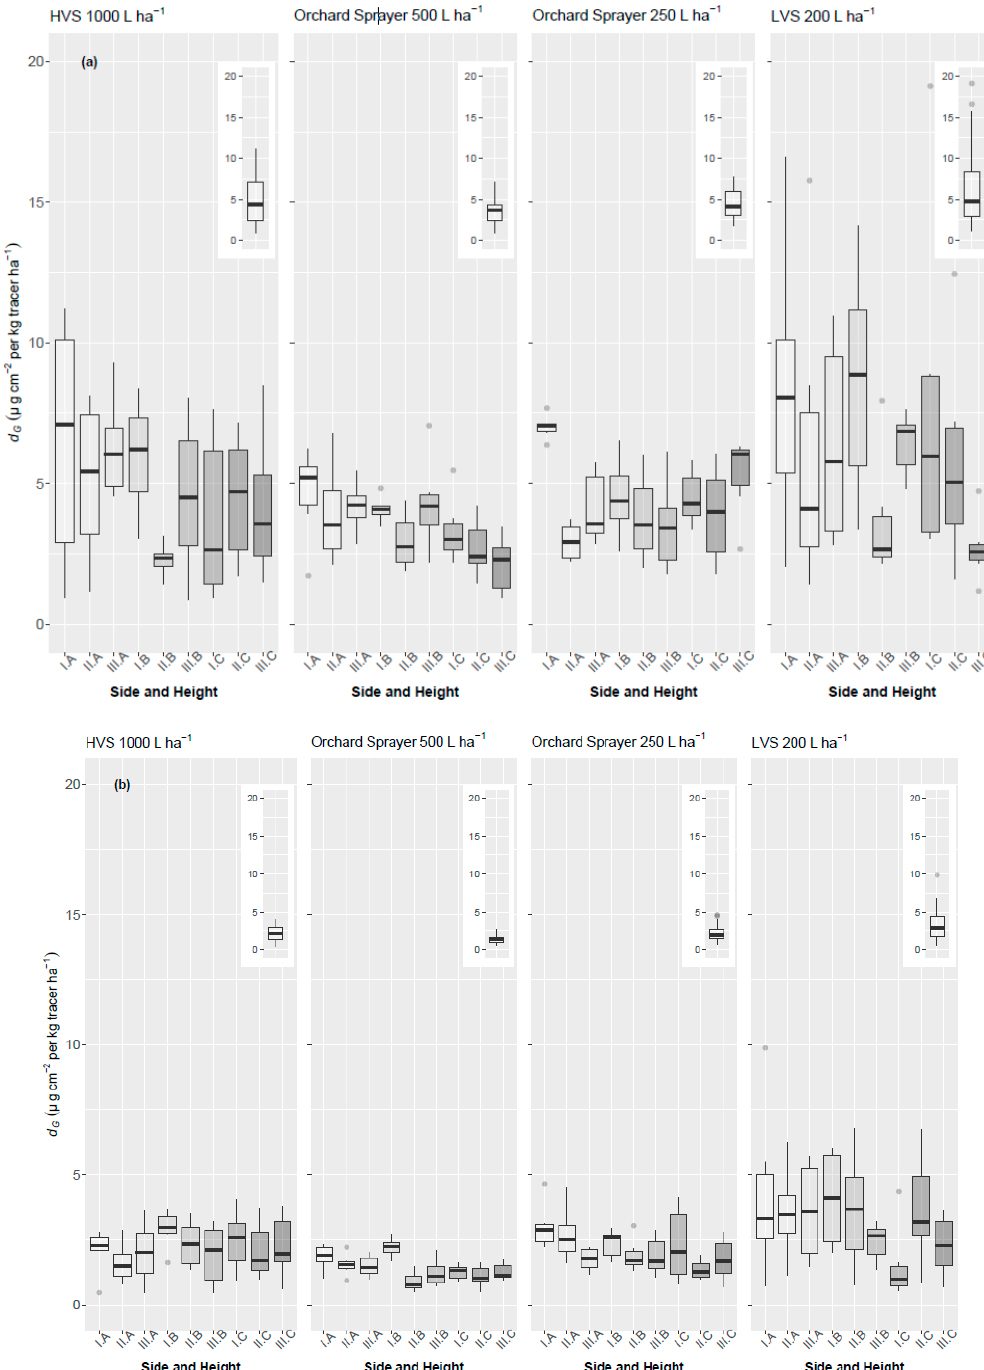
Figure 6. Normalized deposition ( d G ) per kg of tracer per ha ( µ g cm − 2 per kg of tracer per ha) for different sides (II—interior part of the vine) and heights (A-lower—see Figure 3 for details) of the vines for ( a ) the trellis and ( b ) the goblet training system. The insets show d G values for all leaves in each sprayer treatment. Boxplots show the median for each treatment, box boundaries show the 25th and 50th percentile, while whiskers extend to 1.5 times the interquartile range (IQR). Points beyond 1.5 times the IQR are plotted individually. See text for results of statistical